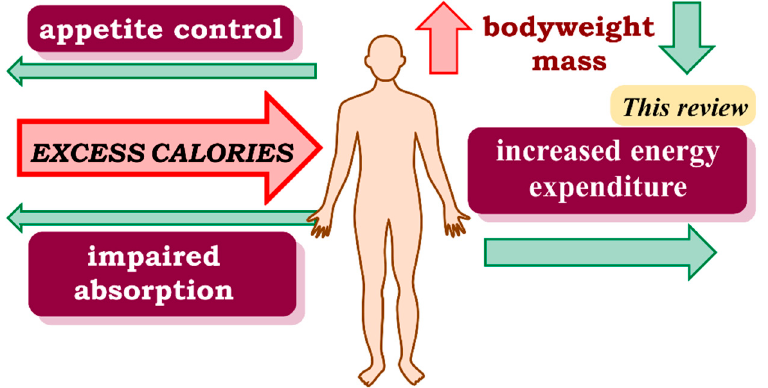
Figure 1. Excess intake of calories causes overweight and obesity. There are three main pharmacological strategies to achieve a caloric deficit. Two of them aim to prevent the storage of excess calories, first by acting on the central nervous system to cause an anorexic effect and regulate appetite, and second by inducing early excretion and thus preventing ingested food from becoming a useful source of calories. The third strategy, and the topic of this review, is the use of drugs that increase energy expenditure by causing the body to use calories already stored in the form of fat.